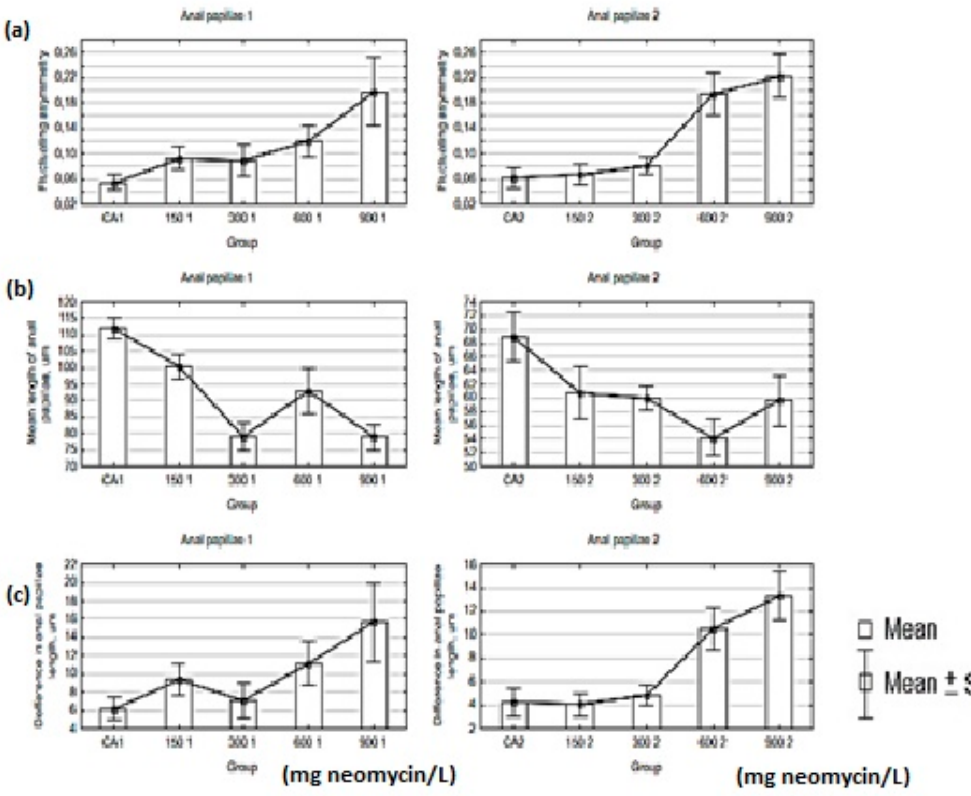
Figure 3. Graph of mean and standard error (SE) of fluctuating asymmetry ( a ), mean length of anal papillae ( b ), and differences in anal papilla length ( c ) for the two studied appendixes. Principal Components Analysis (PCA)